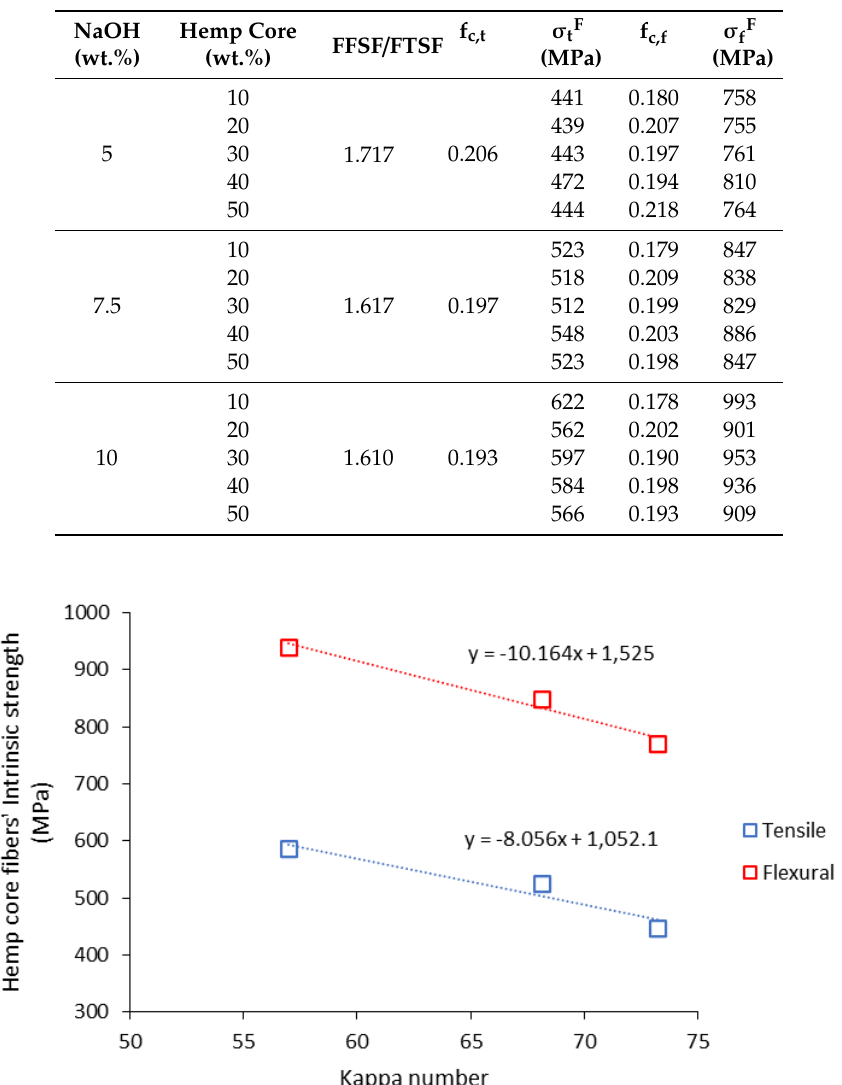
Table 5. Intrinsic tensile ( σ tF ) and flexural strength ( σ fF ) of the hemp core fibers, as well as the tensile (f c,t ) and flexural (f c,f ) coupling factors.